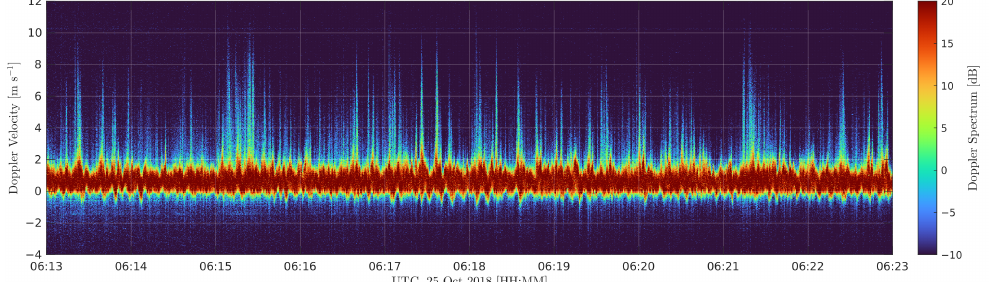
Figure 3. Sample record fragment showing HH-polarization Doppler spectrum at U ≈ 20–25 m s − 1 , θ = 45 ◦